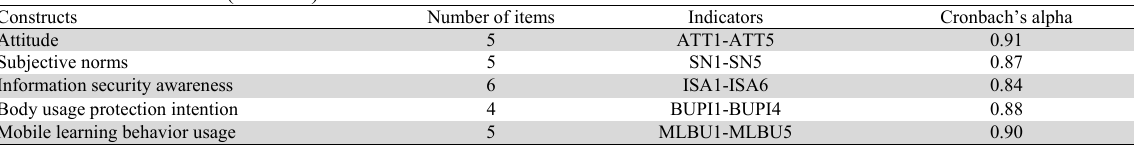
Reliabilities of the scales (N =